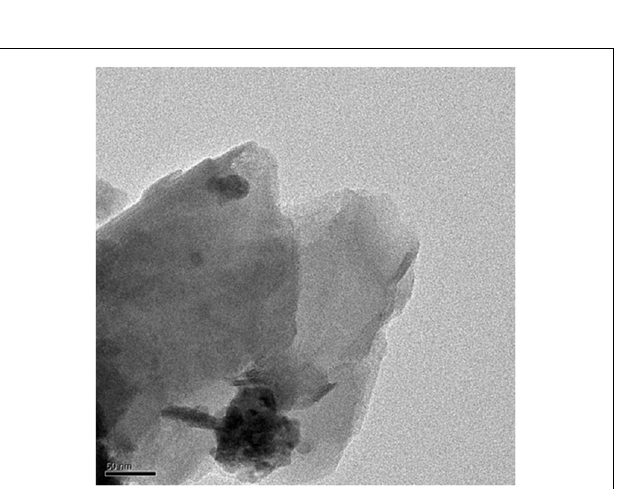
FIGURE 12 | TEM micrograph 1.0% RHA-DGEBA/BMI